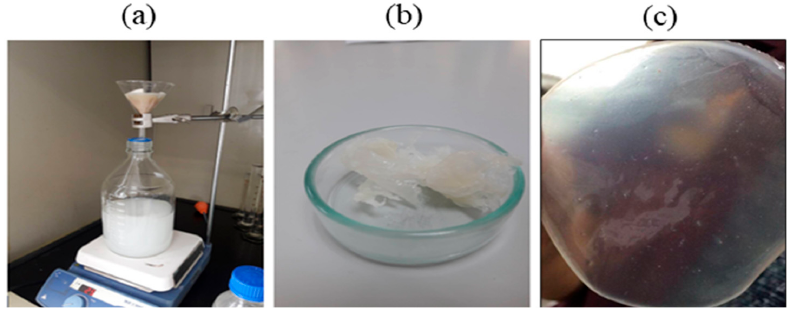
Figure 3. The process of extracting MCL-PHA from the dry cells using chloroform-methanol ( a ). MCL-PHA obtained from extraction ( b ). MCL-PHA sample ( c ).